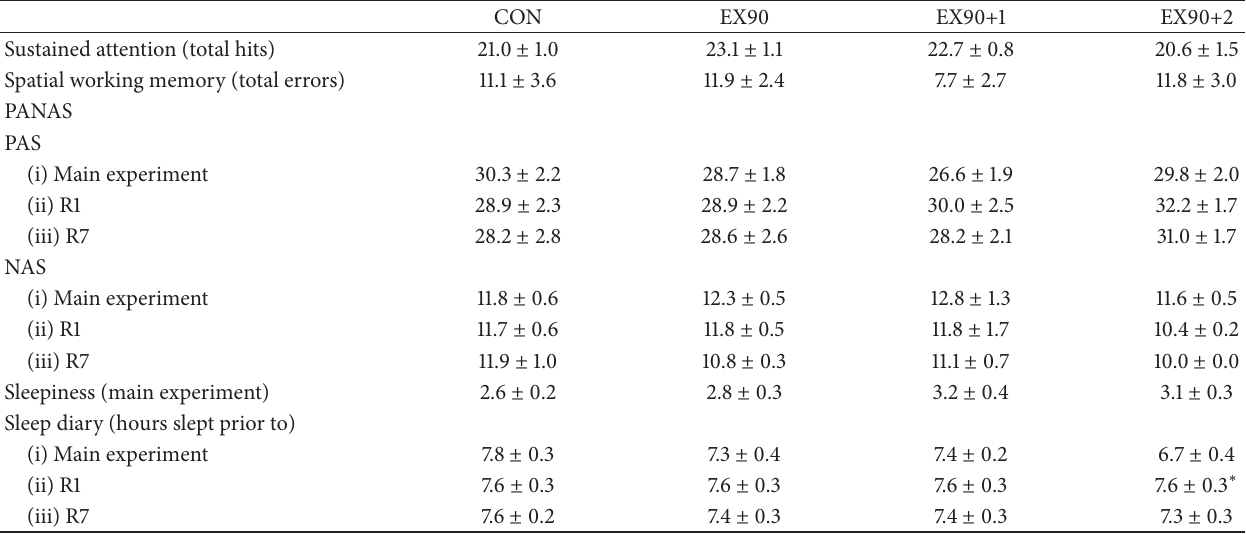
Table 2: Results for tests of sustained attention, spatial working memory, PANAS, sleepiness, physical activity level, and sleep (mean ± SE). ∗ Significantly different from main experiment ( 𝑝 < 0.05